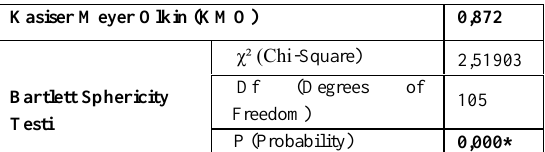
Table 2: KMO and Barlett Results of the Scale of Consumer Perception on Guerrilla Marketing Methods (SCPGMM)